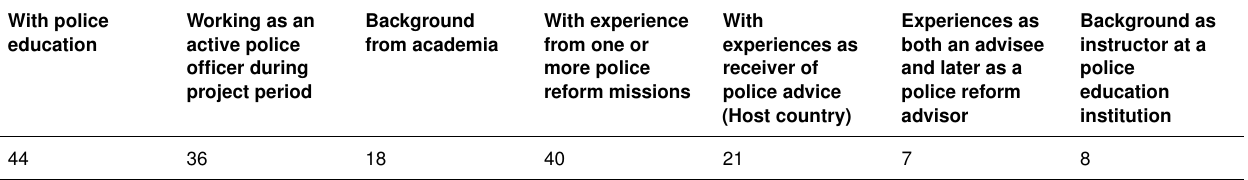
Table 3. PEN members’